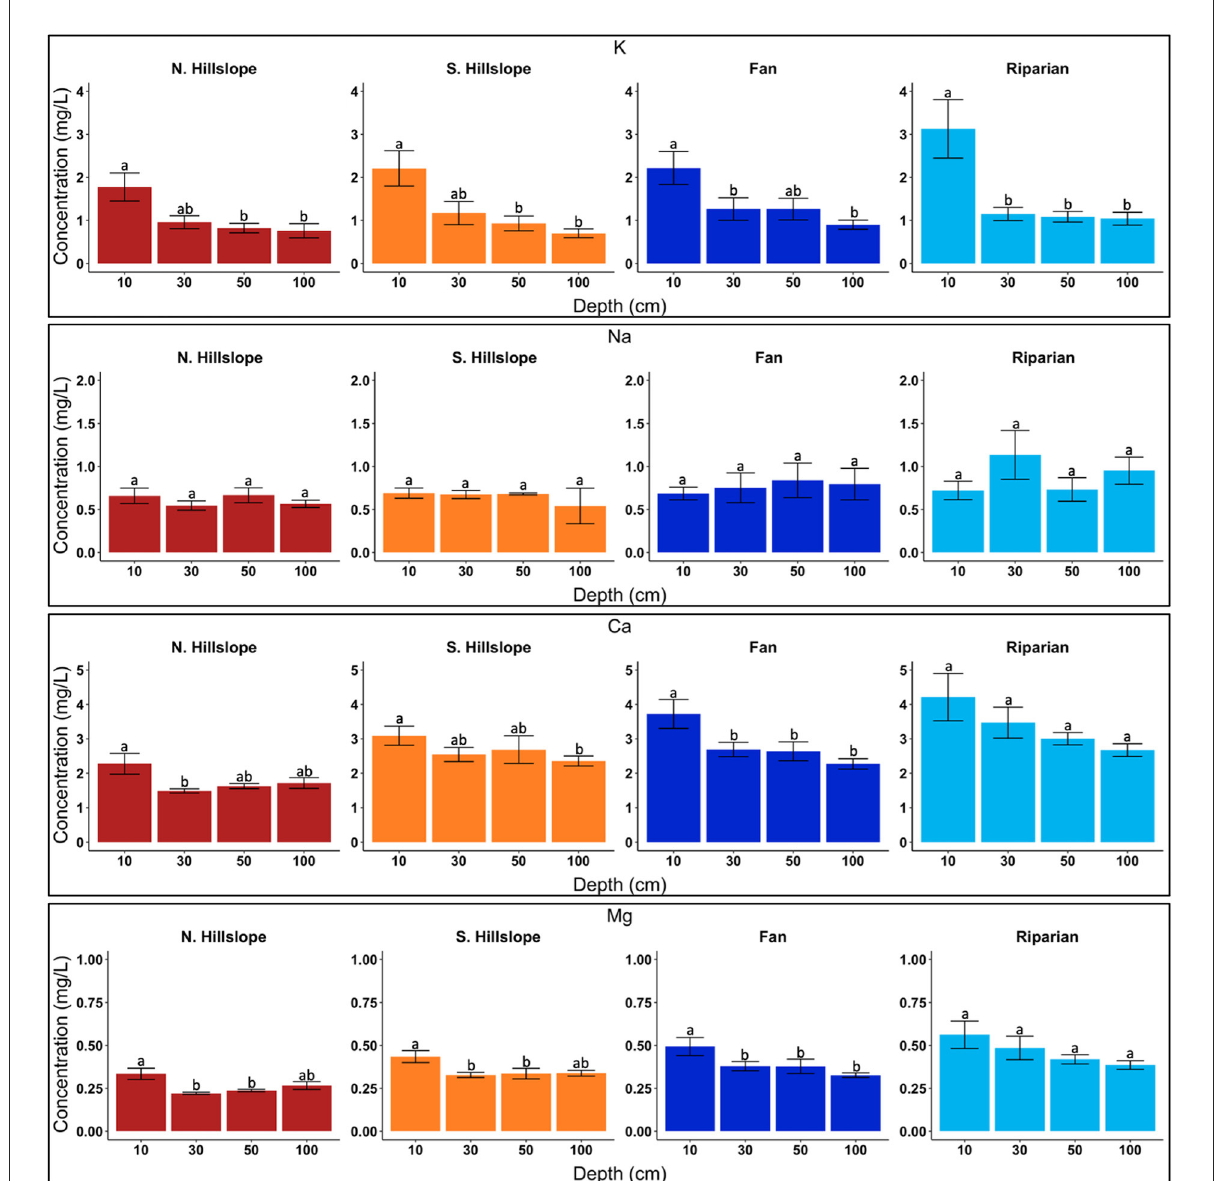
FIGURE2 Bar charts displaying cation concentrations across sampled depths. Letters denote significance among depths at p < 0.05. Data presented are limited to solutes which were used for molar ratio comparisons with stream samples.